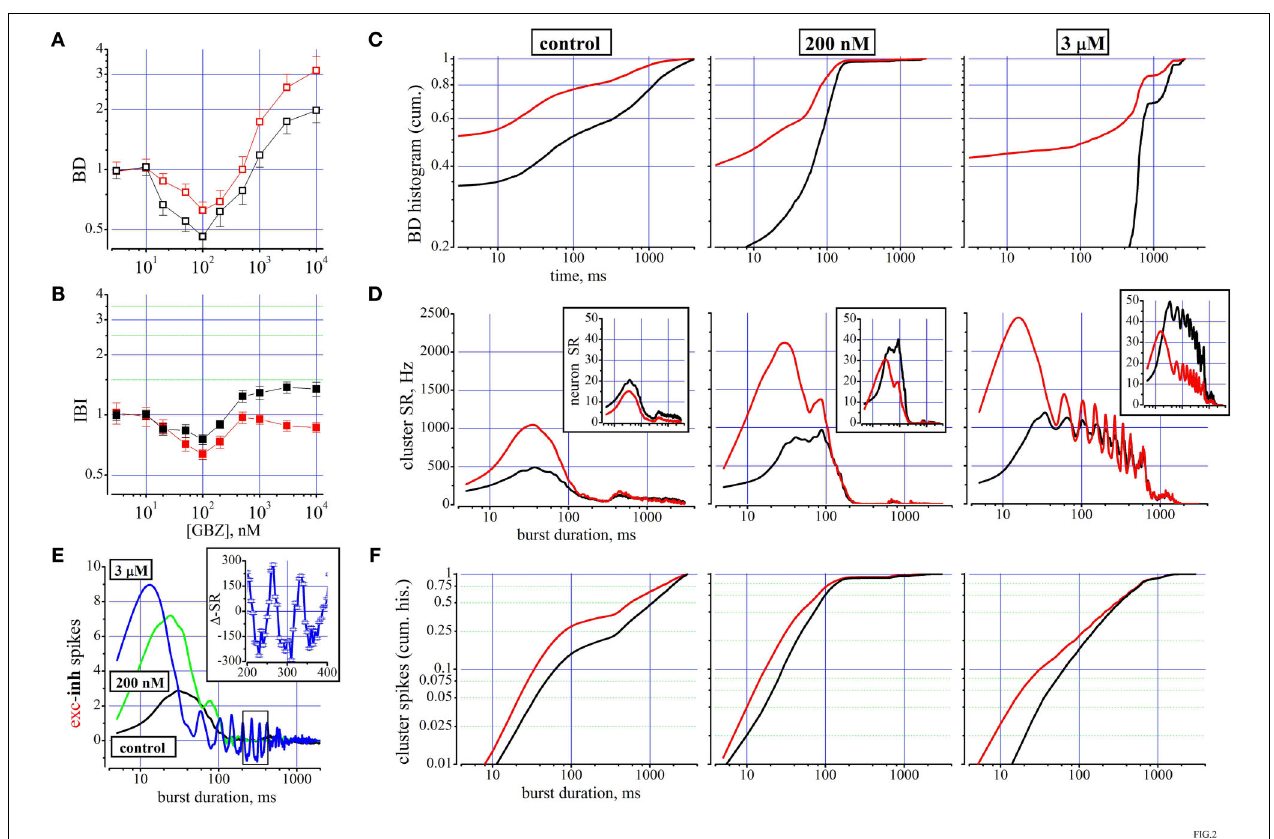
FIGURE 2 | The effects of the GABA disinhibition by gabazine (GBZ). neurons. Insets to each graph illustrate how the same data appear after A (A,B) dose–response curves for IBI and BD evaluated for the excitatory (red division by the number of cells in each cluster (nSR on y -scale). Cubic B-spline symbols) and inhibitory (black symbols) cluster of neurons (total number of option was used. (E) The difference between the number of spikes produced cells: 187, 68, respectively). (C) From a single experiment with two clusters of by the excitatory and inhibitory clusters shown in (D) is plotted in control 69 excitatory (red) and 24 inhibitory (black), the cumulative histograms of BD (black), at 200 nM (green) and at 3 µM GBZ (blue). The small rectangle are shown under control (left), in 200 nM (middle) and in 3 µM GBZ. In control indicates the zoomed region shown in inset where the oscillatory behaviour average data of BD and IBI for the excitatory (inhibitory) clusters were data, at 3 µM GBZ from 200 to 400 ms, of cluster-SR difference is shown with 0.17 ± 0.02 s (0.64 ± 0.07 s) and 11.4 ± 0.6 s (9.7 ± 0.37 s), respectively. bar errors. (F) From the same data shown in (D) , the cumulative histograms (D) From the same network of (C) , the cluster SR versus the time after the versus the time after the burst start are plotted (mean values, red and black for burst start are plotted (mean values, red and black for excitatory and inhibitory excitatory and inhibitory clusters; data evaluated every 5 ms), in control (left), clusters; data evaluated every 5 ms), in control (left), at 200 nM (middle) and at at 200 nM (middle) and at 3 µM GBZ (right) as indicated for the excitatory (red) 3 µM GBZ (right) as indicated for the excitatory (red) and inhibitory (black) and inhibitory (black)